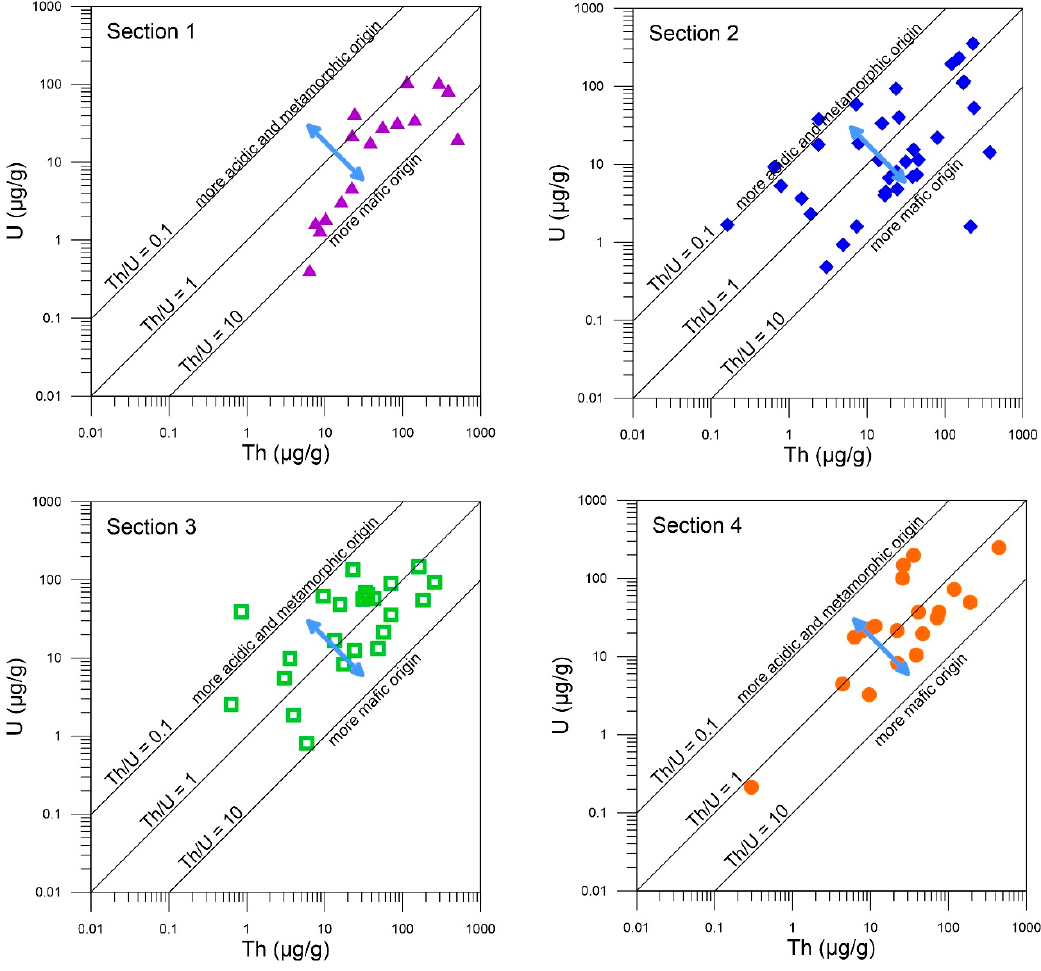
Figure 5. Detrital apatite compositions in the four sections of Core S3 from the SOT plotted on a Th vs. U binary plot [66].